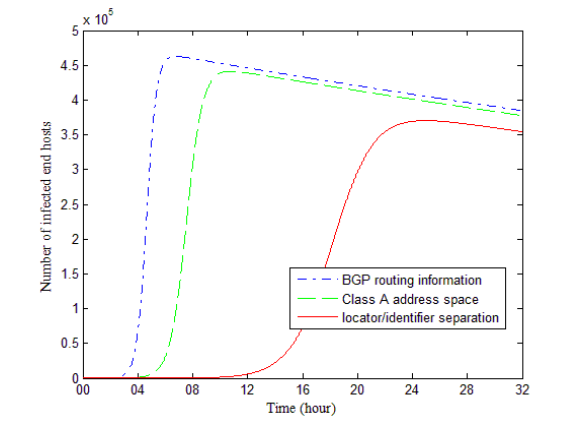
Fig. 2. Number of infected end hosts with different scanning spaces.